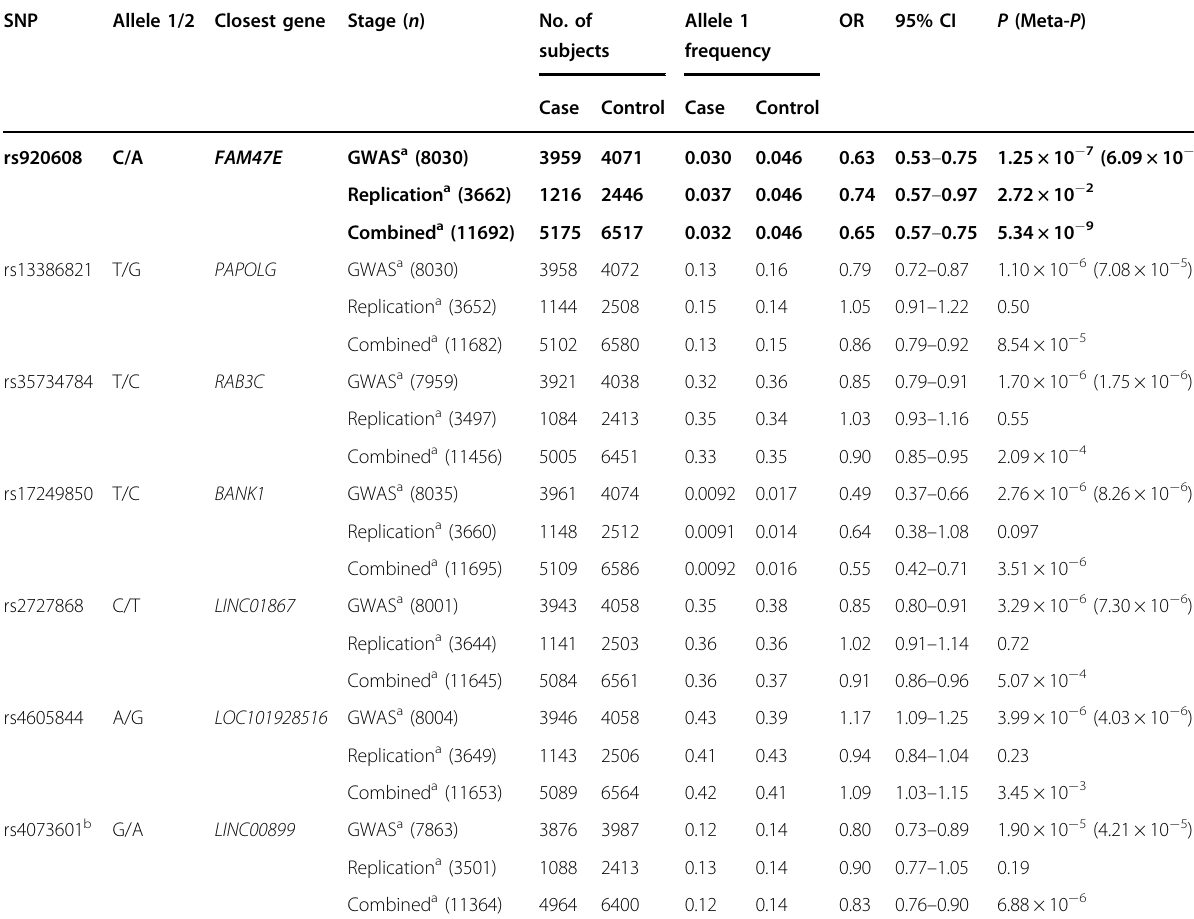
Table 1 Summary statistics of newly identi fi ed regions signi fi cantly associated with Alzheimer ’ s disease.